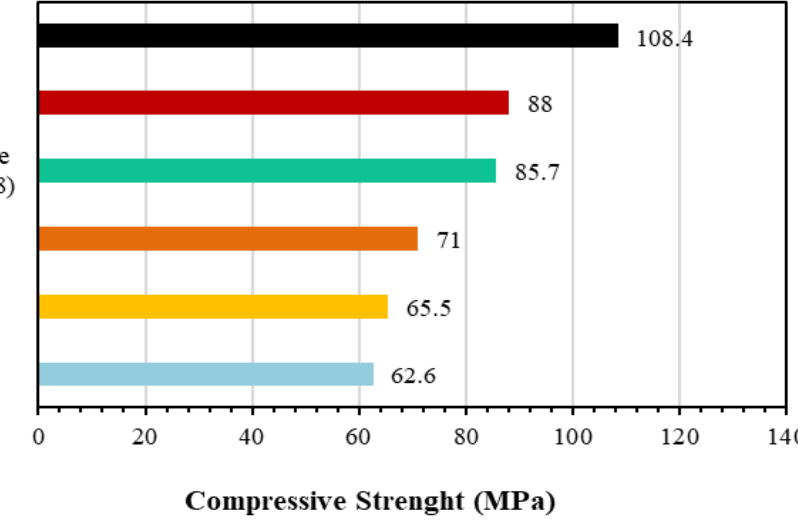
Figure 7. Comparison between the SIFC compressive strength and the literature at 28 days. Figure 9. Comparison between the SIFCON compressive strength and the literature at 28